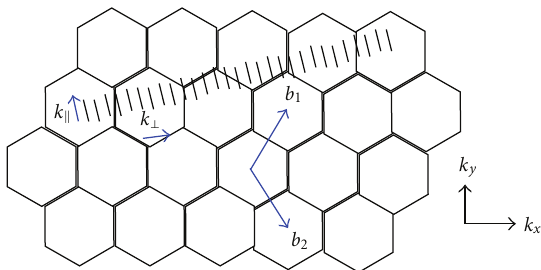
Figure 5: Vectors definition for the reciprocal lattice of